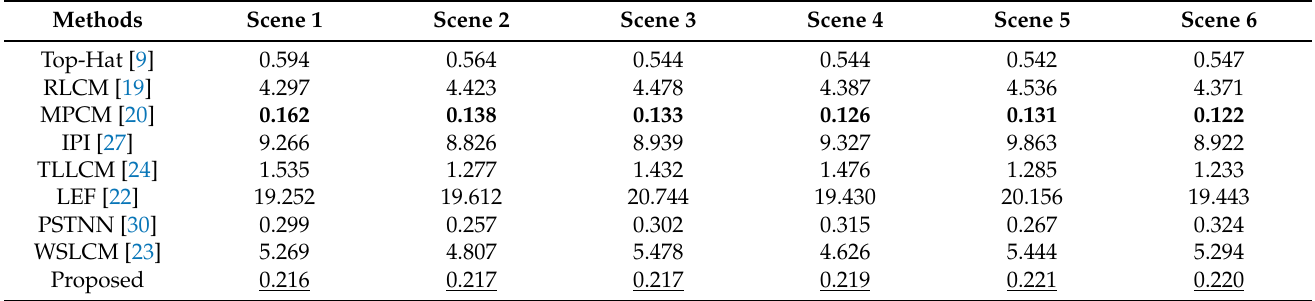
Table 5. Average time consumption of a single frame for all methods in six real scenes. (Unit: